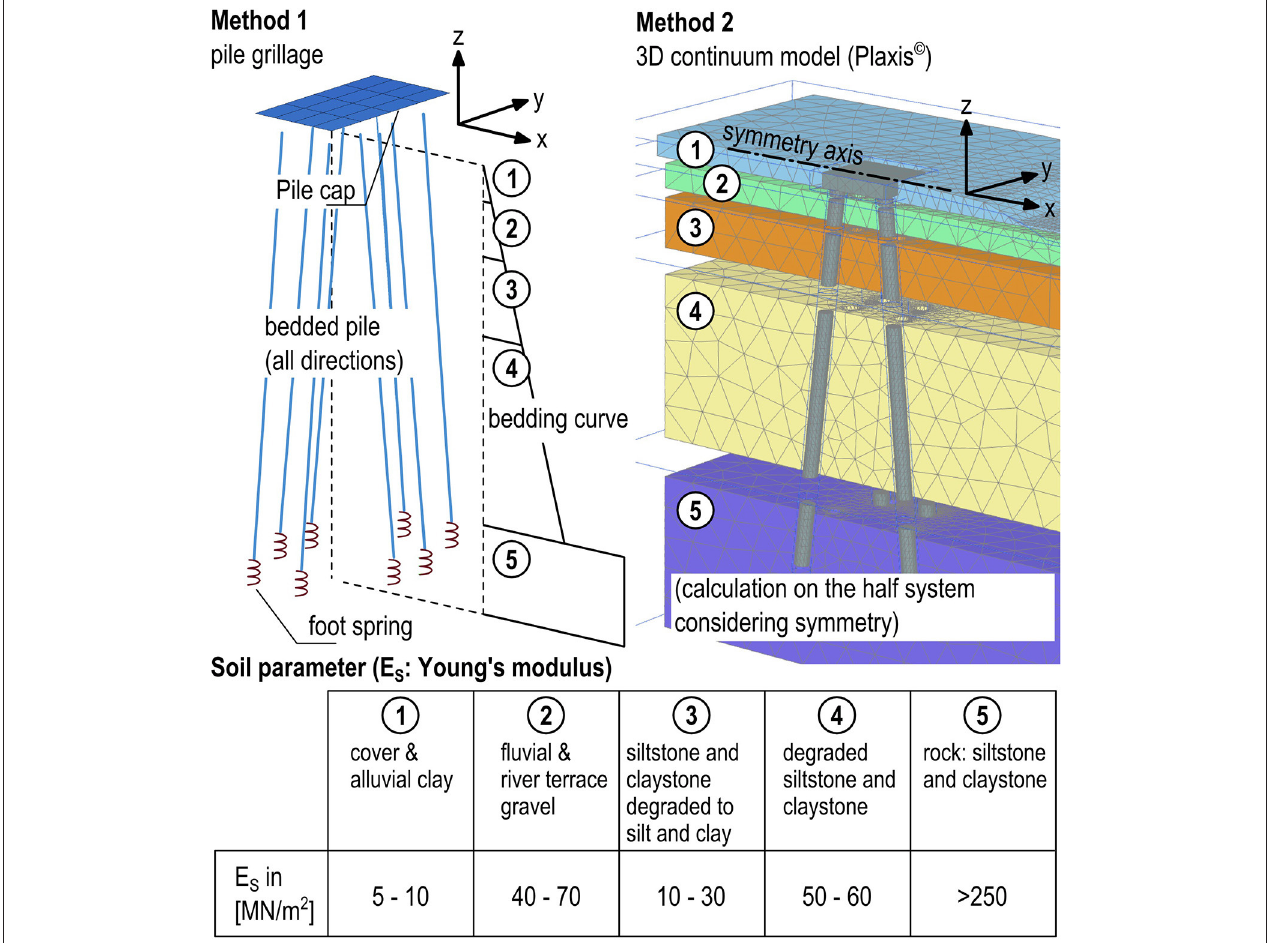
FIGURE 9 | Comparison of the two methods for the calculation of the deep foundation